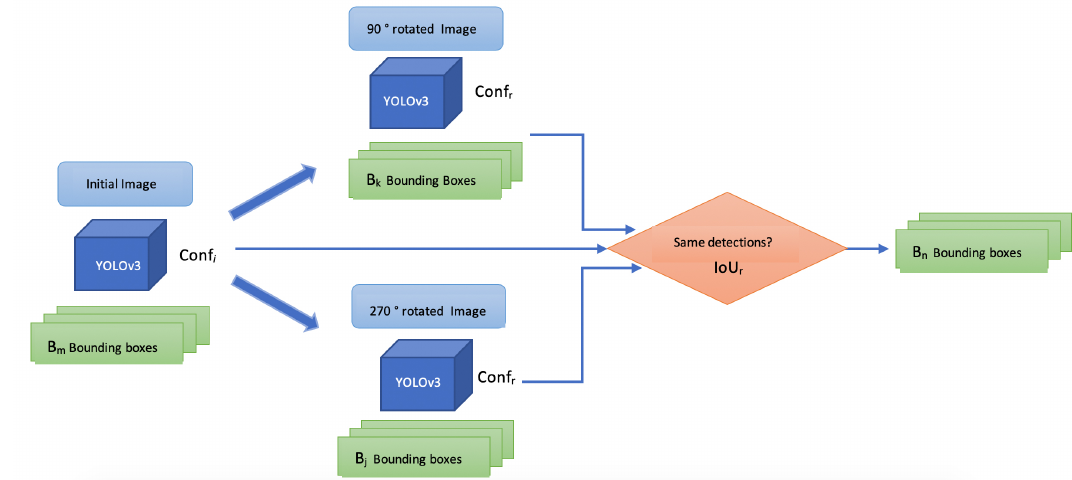
Figure 14. Flowchart of fall detection with pose